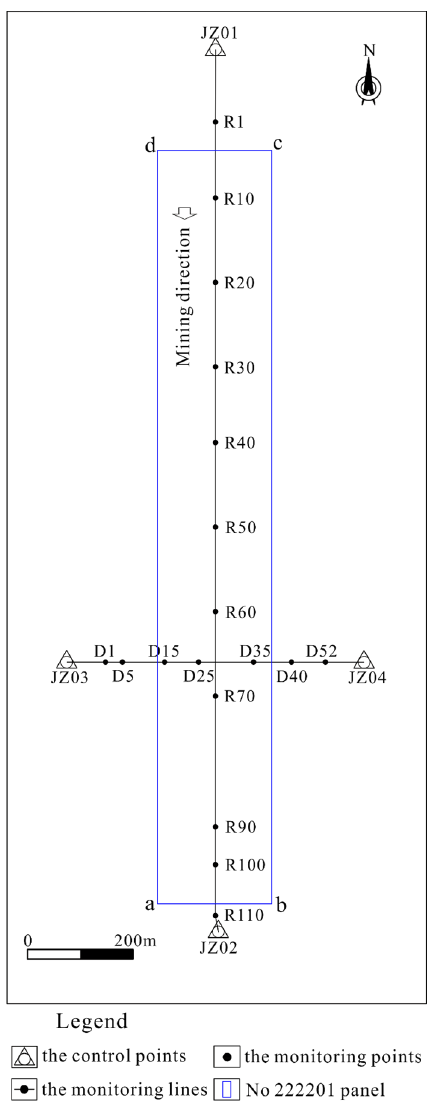
Figure 5. The layout of subsidence monitoring points on the surface above panel No. 222201. A total of 110 monitoring points (R1–R110) are arranged along the mining direction. The distance between two adjacent monitoring points is 20 m from R1 to R80 and 10 m from R80 to R110. A total of 52 monitoring points (D1–D52) are arranged perpendicular to the mining direction, and the distance of two adjacent monitoring points is 10 m.